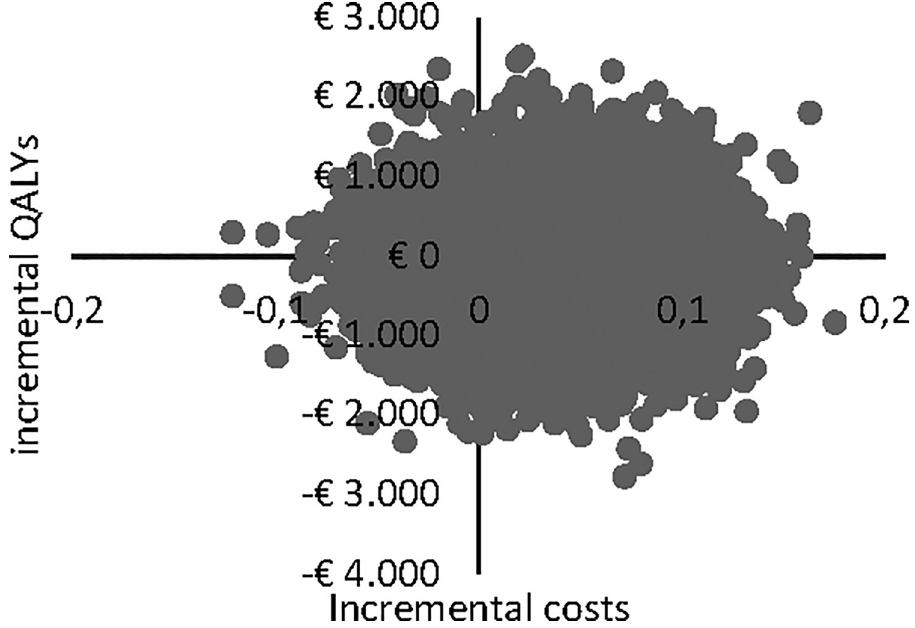
Fig 2. CE plane for healthcare